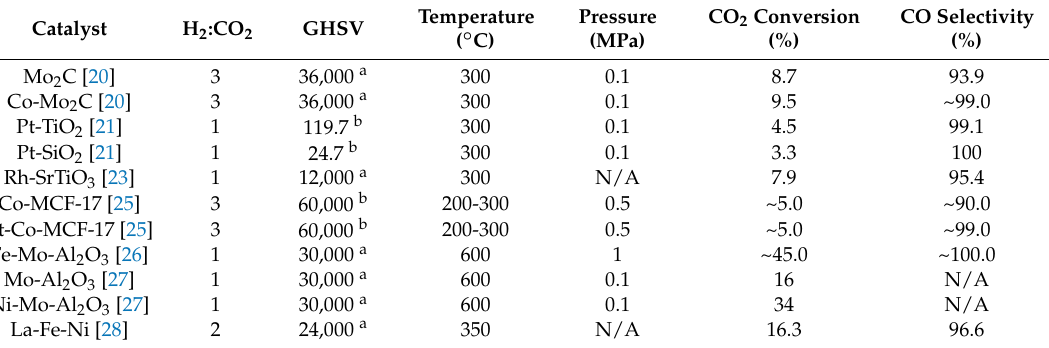
Table 1. Catalytic performance of several catalytic systems for CO 2 hydrogenation into CO, in terms of CO 2 conversion and CO selectivity, along with the reaction